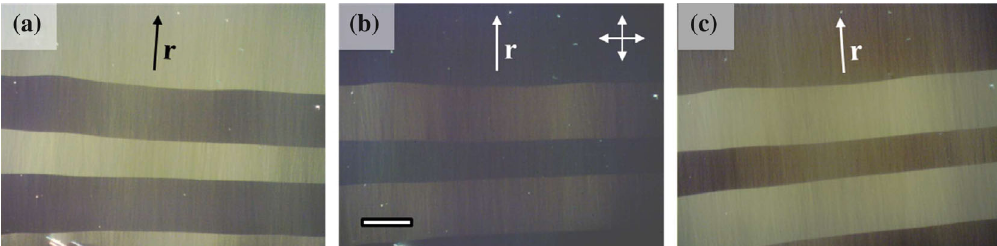
FIG. 19. Alternating monochiral N domains of BP12 observed between crossed polarizers ( T ¼ 108 . 8 °C, d ¼ 9 . 8 μ m). In both TB kinds of domains, the optic axis N is parallel to the rubbing direction r . When r is parallel to the input polarizer (b), both kinds of domains appear dark. When the sample is rotated by (cid:4) 4 ° [(a) and (c)], a strong transmittance contrast appears between the two kinds of domains. The inversion of this contrast with the sign of the rotation indicates the different signs of the chirality of adjacent domains. (Scale bar 100 μ m.)